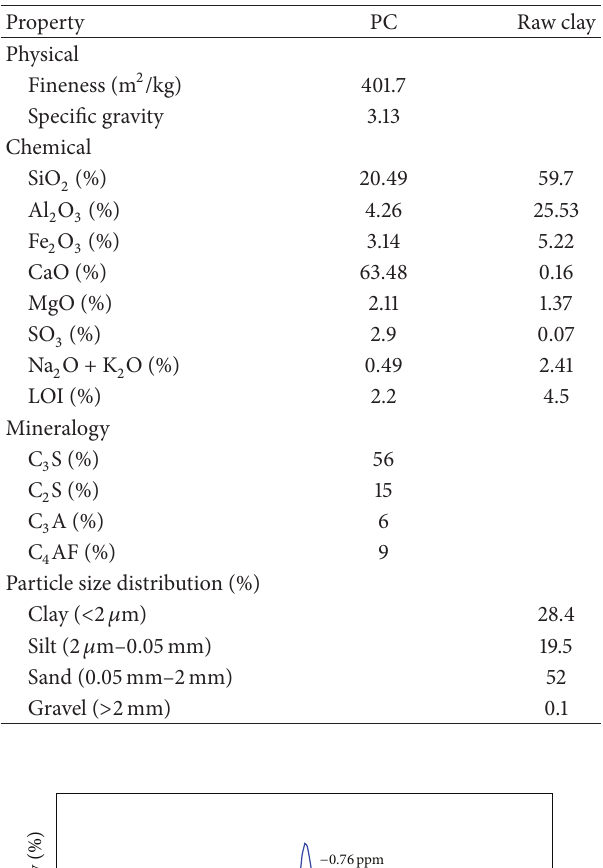
Table 1: Properties of Portland cement and raw clay.